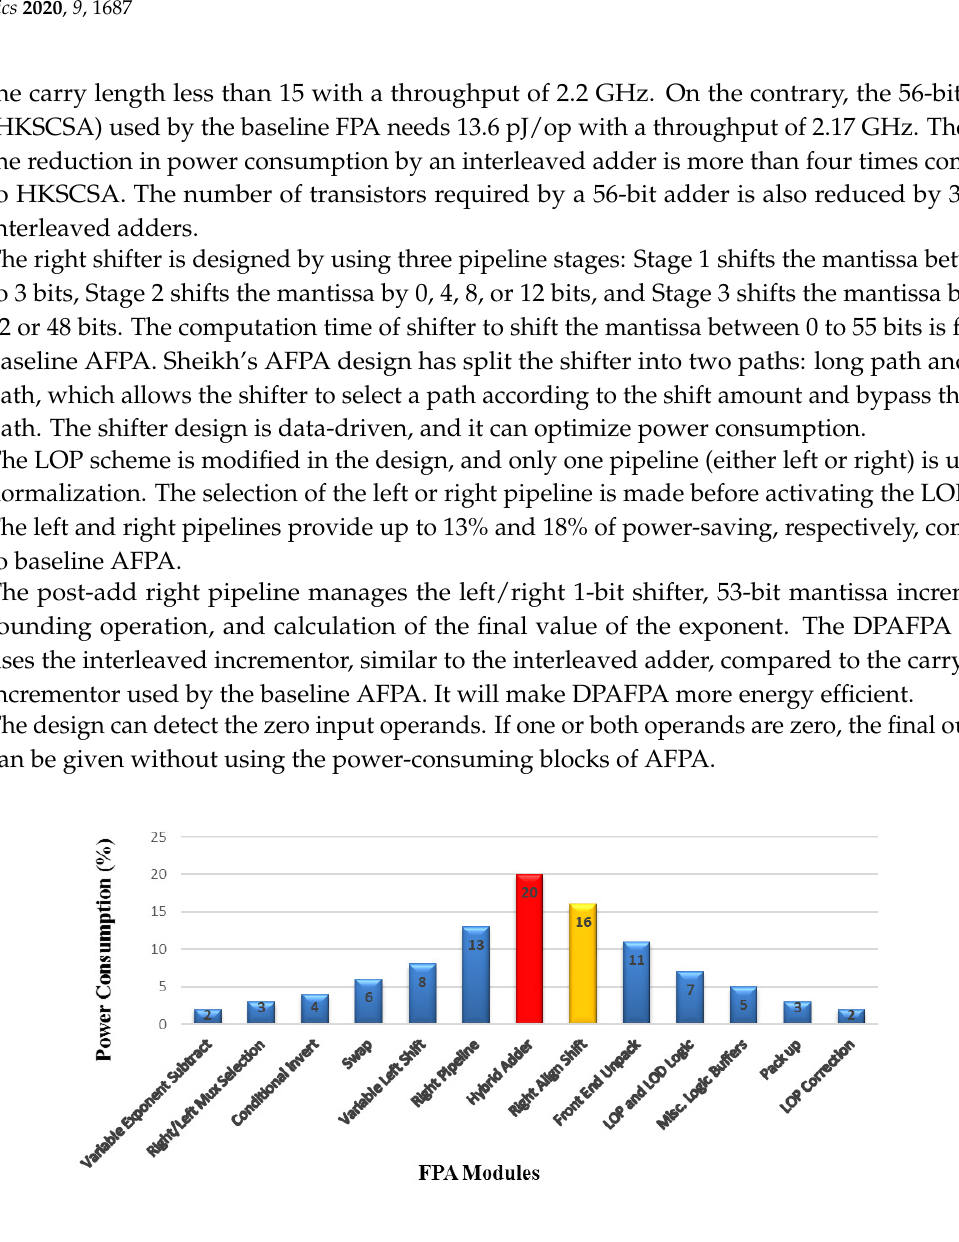
Figure 8. Data encoding protocols [136].